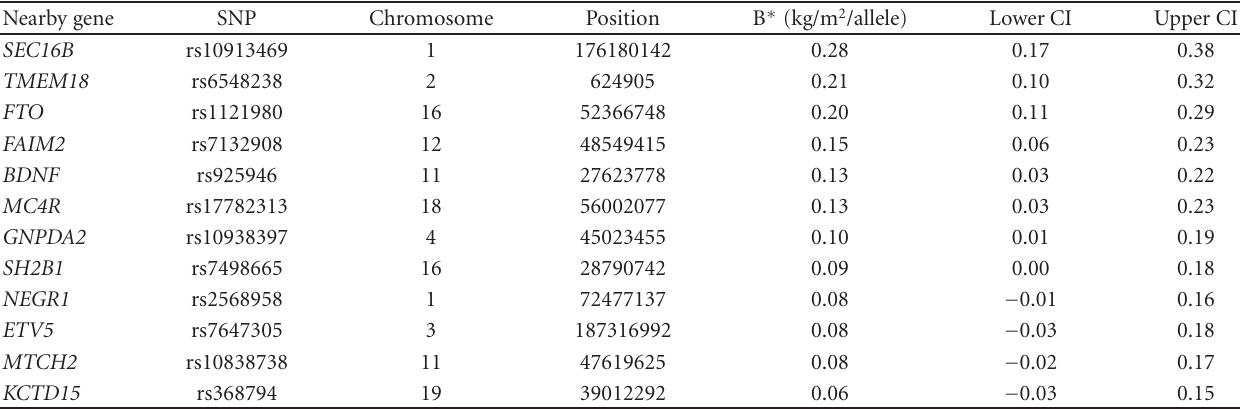
Table 2: Associations between individual BMI-increasing variants and BMI at age 20 years in 8,156 EPIC-Norfolk women. Nearby gene